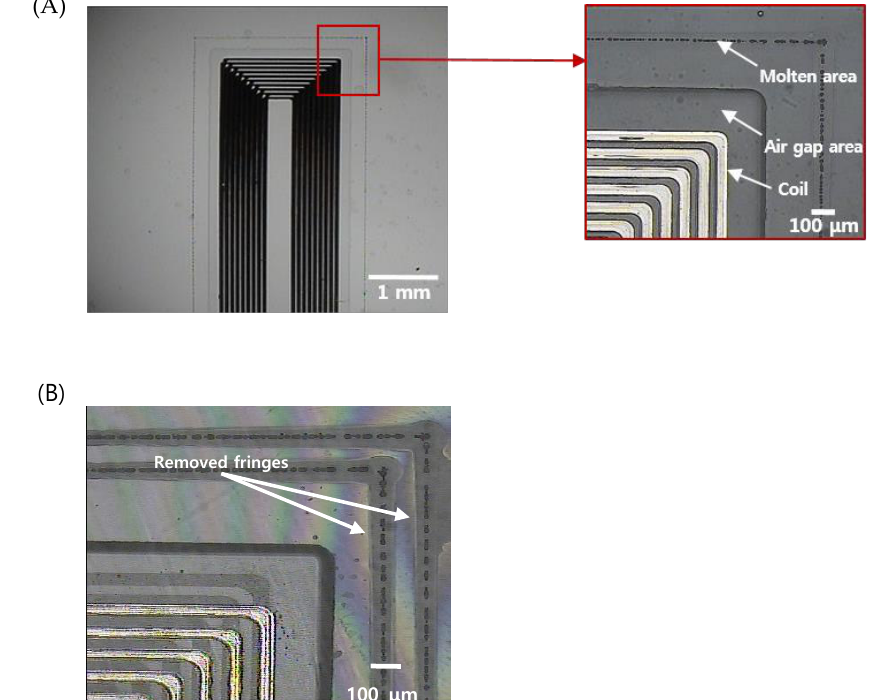
Figure 5. ( A ) An optical image of the sealed implantable blood pressure sensor using ultrafast laser micro-welding (the total length of the micro-welded track is 31.2 mm) ( B ) zoomed image of the corner indicating successful welding (discontinuity of interference pattern due to the welding track is shown) .